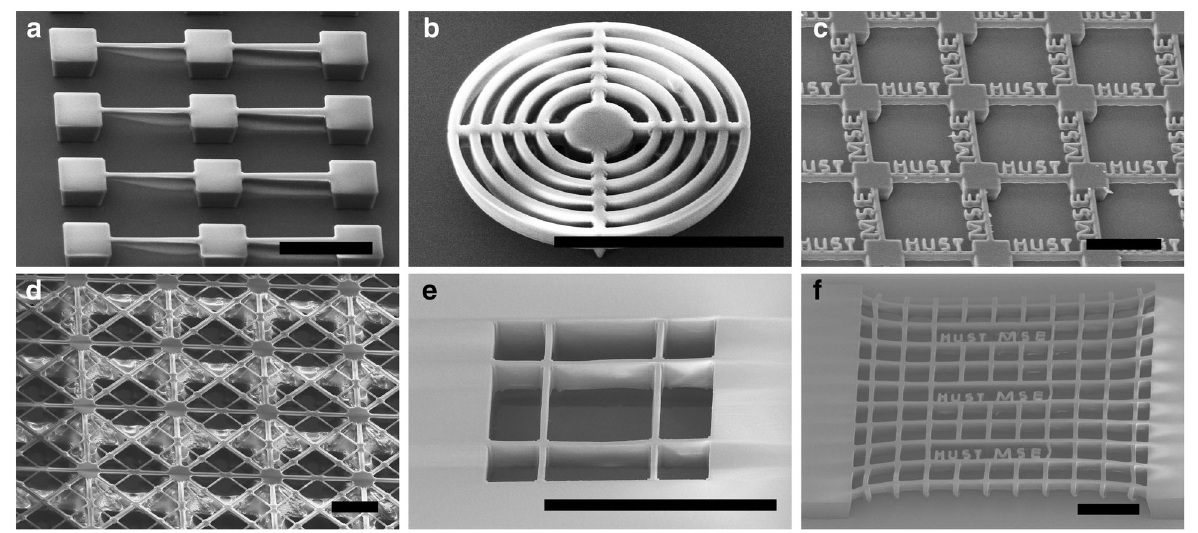
Fig. 6 3D suspended photoresist structures. a Suspended beams with gradient thickness, b suspended concentric rings, c suspended word structures, and d multilayer suspended meshes, where the photoresist is NR26-25000P. e Suspended SU-8 mesh. f Suspended SU-8 meshes with word patterns. The scale bars are 100 μ m. The suspended structures in d is achieved by a two-step exposure, and the others are fabricated with a one-step